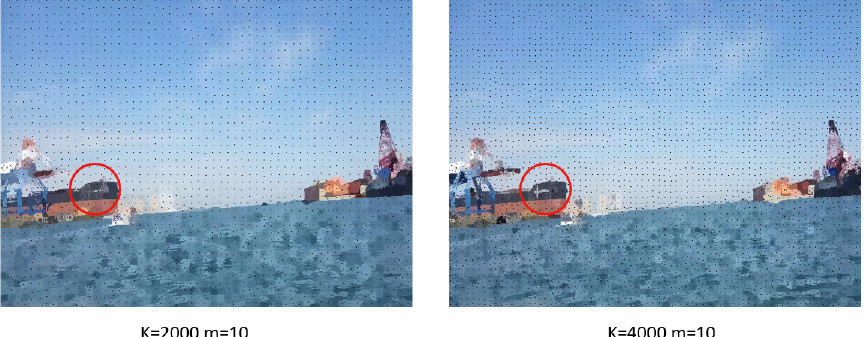
Figure 8. For m = 10, iteration=10, the output of the SLIC algorithm module for K = 2000 and K =